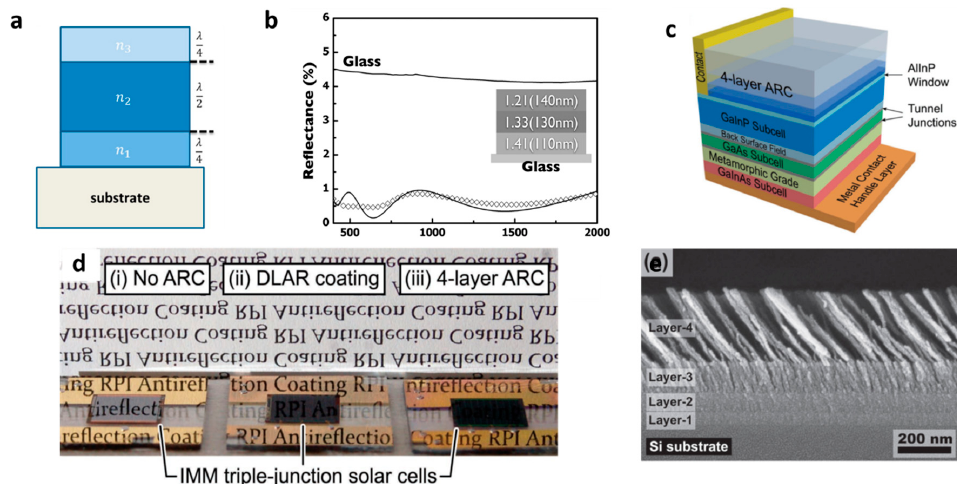
Figure 3. ( a ) Schematic representation of ( a ) multilayer interference coatings (three-layer system